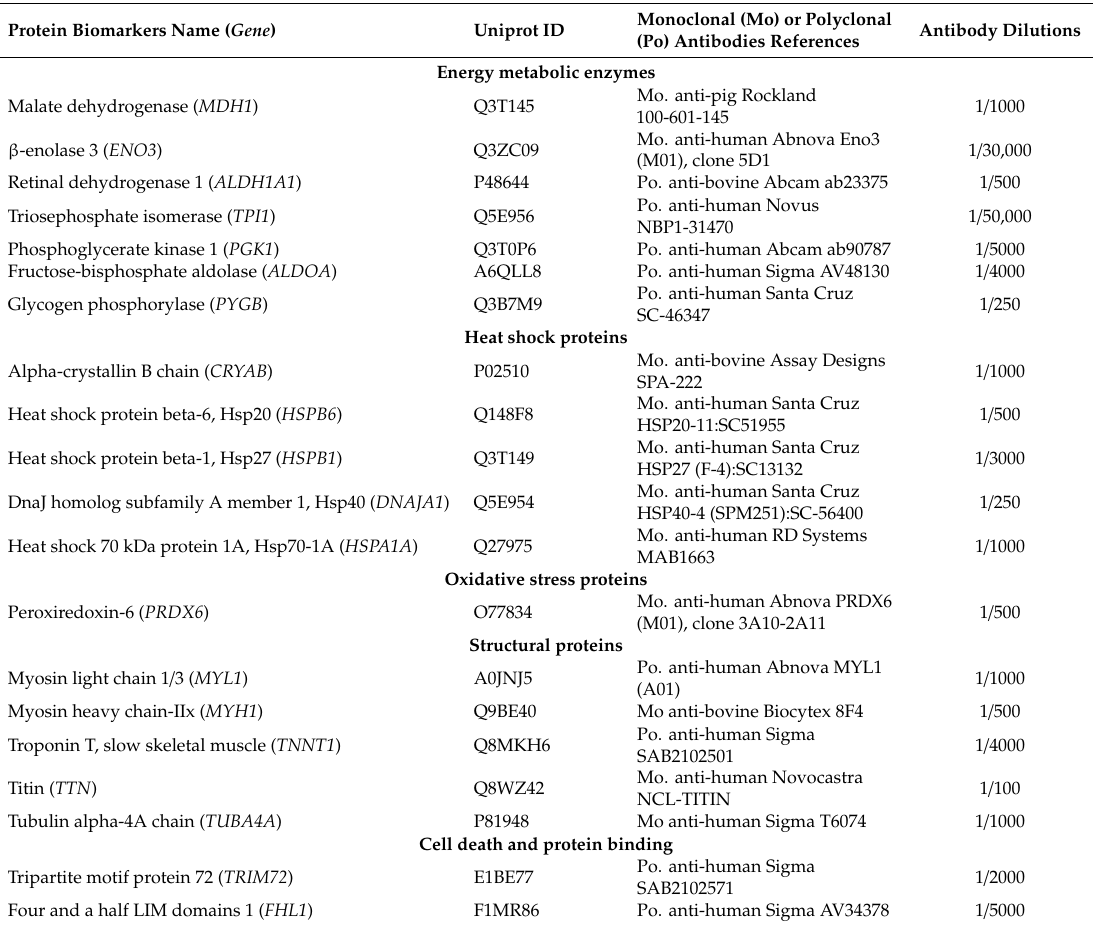
Table 1. List of the 20 protein biomarkers quantified using the Reverse Phase Protein Array (RPPA) technique 1